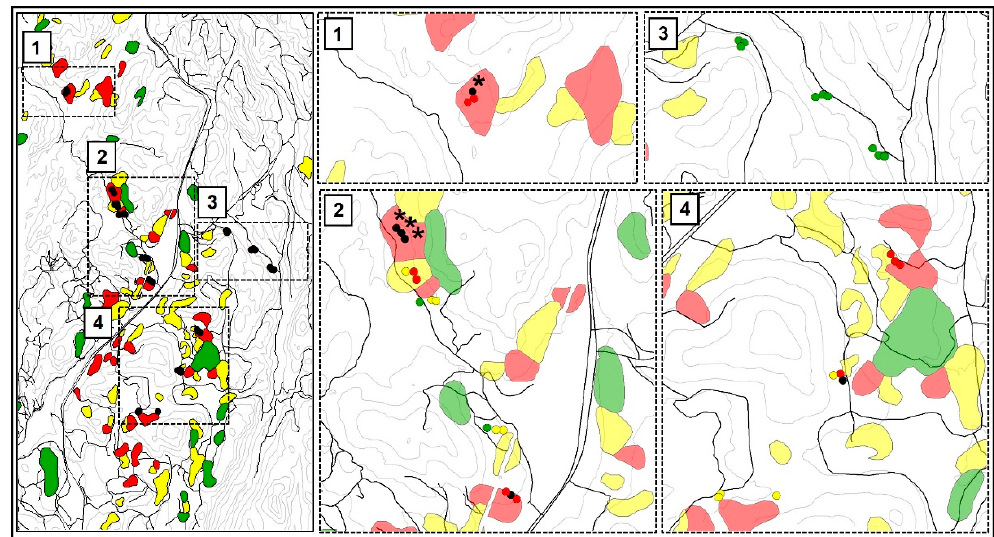
Figure 6. Aerial survey maps showing the hemlock looper defoliation patches in the Reserve faunique des Laurentides in Quebec, Canada, in 2013. Three severity levels are shown: light (green), moderate (yellow), and heavy (red). The black dots on the left map show the study plot locations. The colored dots on maps 1–4 show corresponding ground-level defoliation estimates (light, moderate and heavy being green, yellow, and red dots, respectively, and the black dots express the dominance of dead trees). Black stars on maps 1 and 2 express the stands in which dead trees were dominating after the 1st year of the outbreak (2012).